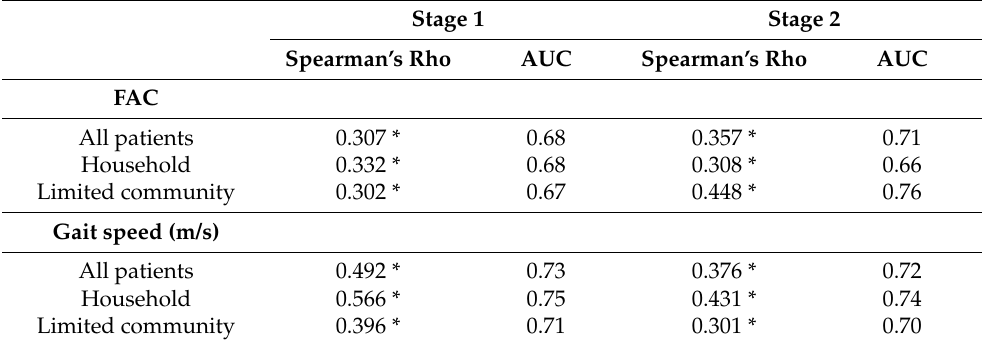
Table 4. Responsiveness statistics for the STS by